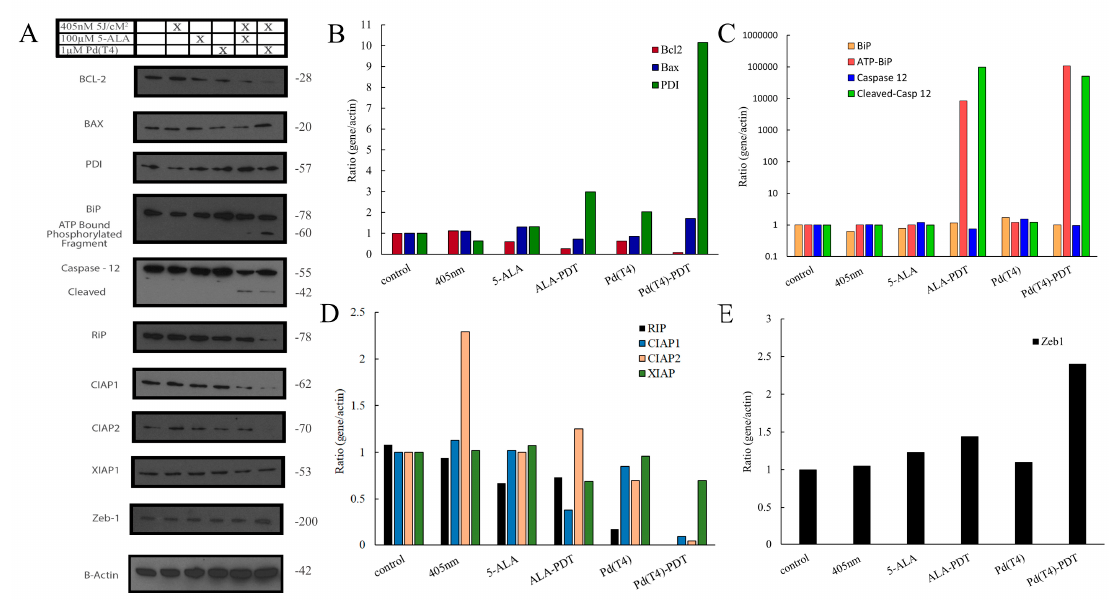
Figure 8. Protein expression in C918 cells exposed to sub-lethal PDT dose. Total protein was isolated from C918 cells alone, exposed to 5-ALA (0.1 mM) or Pd(T4) (1 µM) with or without 5 J/cm 2 of 405 nm alone.Sodium dodecyl sulfate polyacrylamide gel electrophoresis (SDS-PAGE) was performed followed by Western blot analysis on protein isolated from cells 6 h post-PDT treatment ( A ). ImageJ software was used to quantify protein levels, which were grouped into proteins associated with apoptosis ( B ), endoplasmic stress ( C ), necroptosis ( D ), and other mechanisms ( E ). BiP: binding immunoglobulin protein; RIP: receptor interacting protein; CIAP: cellular inhibitor of apoptosis protein; XIAP: X-linked inhibitor of apoptosis; Zeb1: zinc finger E-box binding homeobox